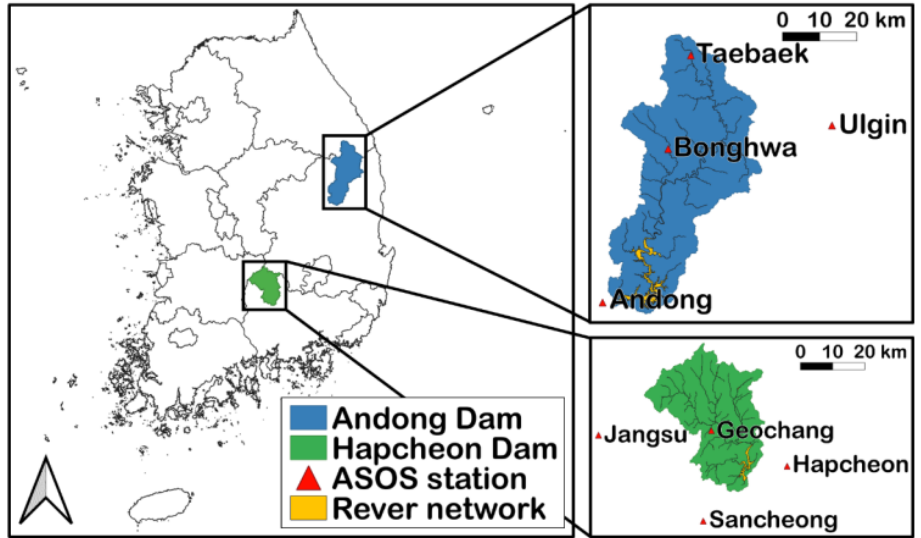
Figure 1. Location of Andong Dam Basin and Hapcheon Dam Basin. Monthly precipitation, daily minimum and maximum surface air temperature, daily average wind speed, daily average dew point temperature, and monthly average dam inflow data were obtained and used from the Korea Meteorological Administration’s open MET data portal [43] and the National Water Resources Management Information System [44]. The data period was from January 1991 to December 2021. Figure 2 shows monthly precipitation, monthly potential evapotranspiration, and monthly inflow in each basin. The monthly potential evapotranspiration in Figure 2 was calculated using the Penman–Monteith method, which is calculated using the daily minimum and maximum daily temperature, daily average wind speed, and daily average dew point